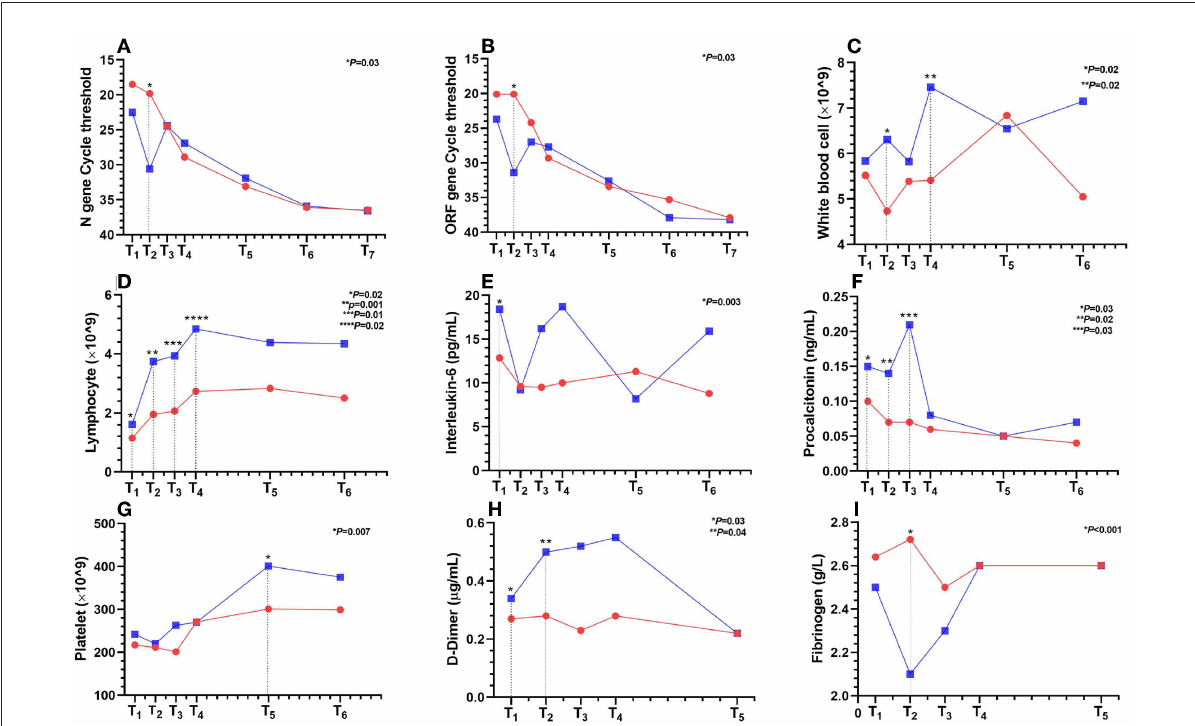
FIGURE3 Dynamic changes in laboratory results for seven time periods from T 1 to T 7 within 28 hospitalization days after admission. T 1 to T 7 represent the following: T 1 ≤ 1 day; 1 < T 2 ≤ 3; 3 < T 3 ≤ 5; 5 < T 4 ≤ 7; 7 < T 5 ≤ 14; 14 < T 6 ≤ 21; 21 < T 7 ≤ 28 days. The red line represents the iVD group, n = 8–80 per condition. The blue line represents the sVD group, n = 4–36 per condition. Points on the line chart represent mean or median. (A) N gene cycle threshold; (B) ORF1ab gene cycle threshold; (C) white blood cells; (D) lymphocytes; (E) interleukin-6; (F) procalcitonin; (G) platelets; (H) D-dimer; (I) fibrinogen.